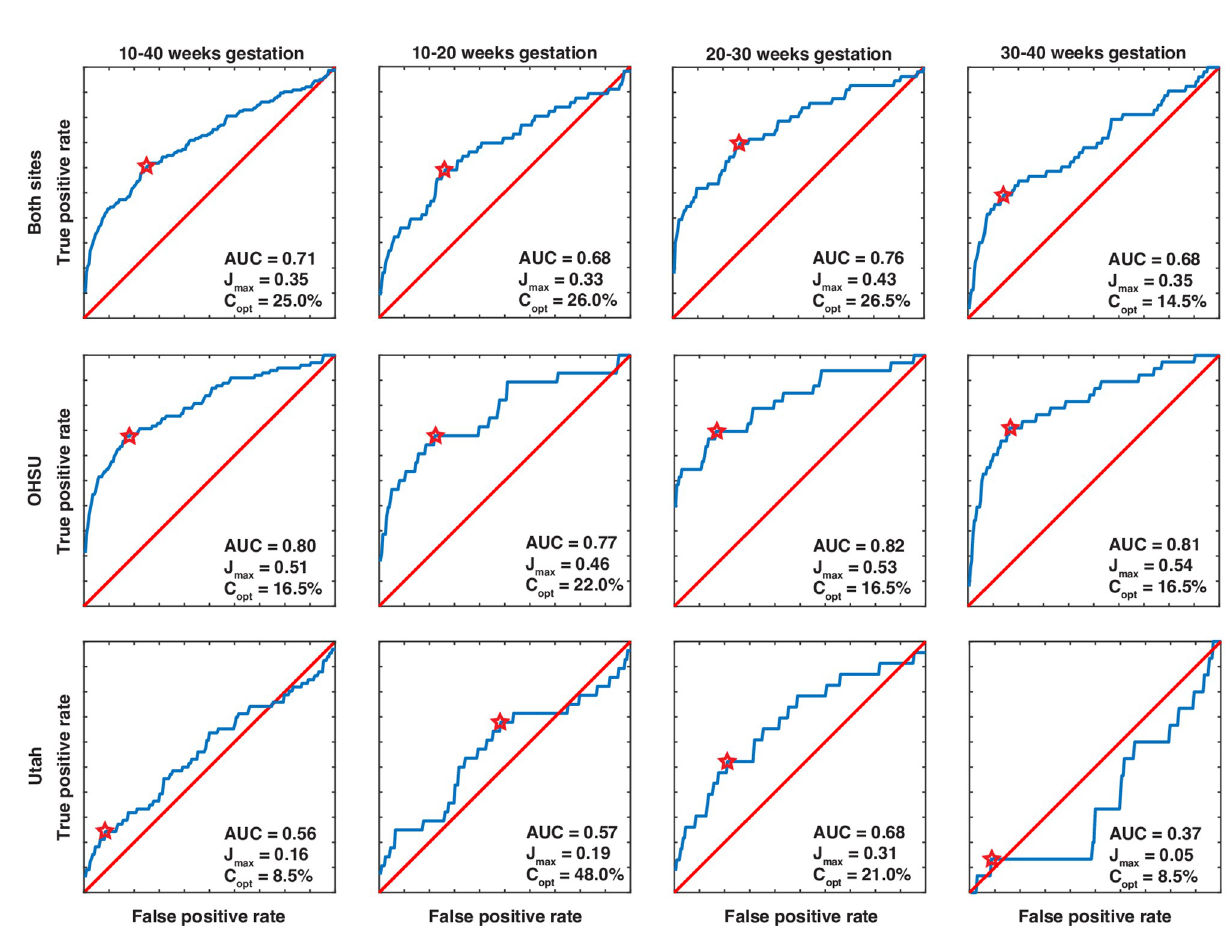
Fig 5. Receiver operator characteristic (ROC) curves for T2 � prediction of PA pregnancies. The points where Youden’s J is maximized are indicated by the stars. Area under the curve (AUC), J max , and the corresponding optimal cutoff threshold in T2 � percentile relative to UN (C opt ) are given in the figure legend for each